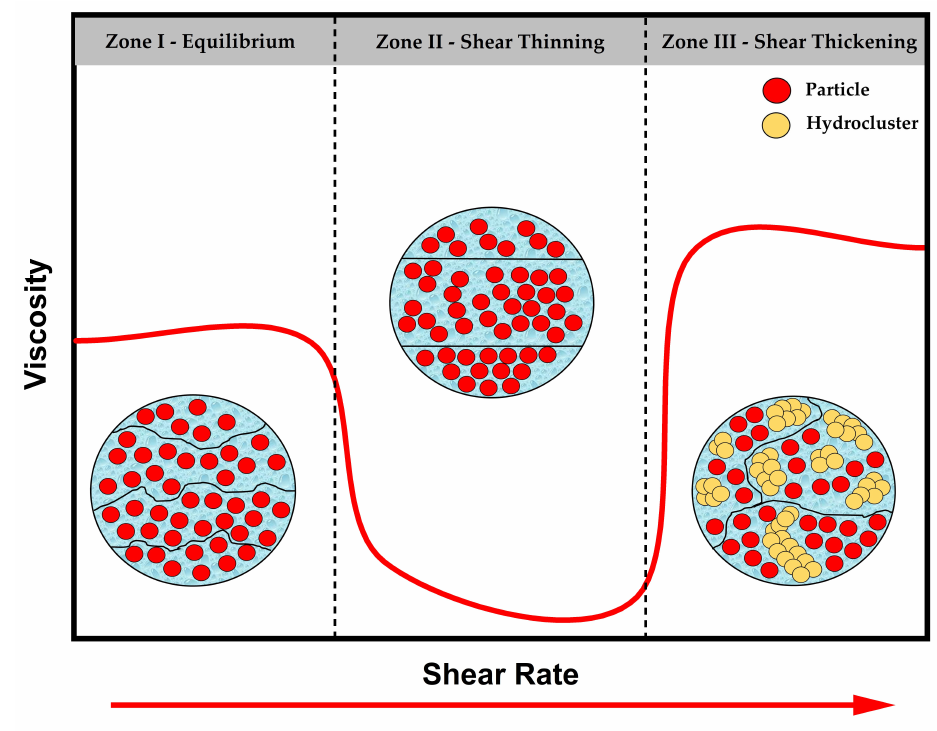
Figure 2. Schematic representation of the rheological behavior of a typical